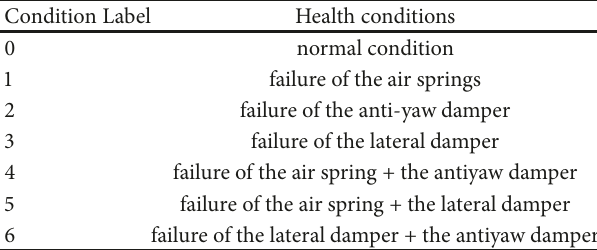
Table 1: Seven kinds of health conditions of the bogie.